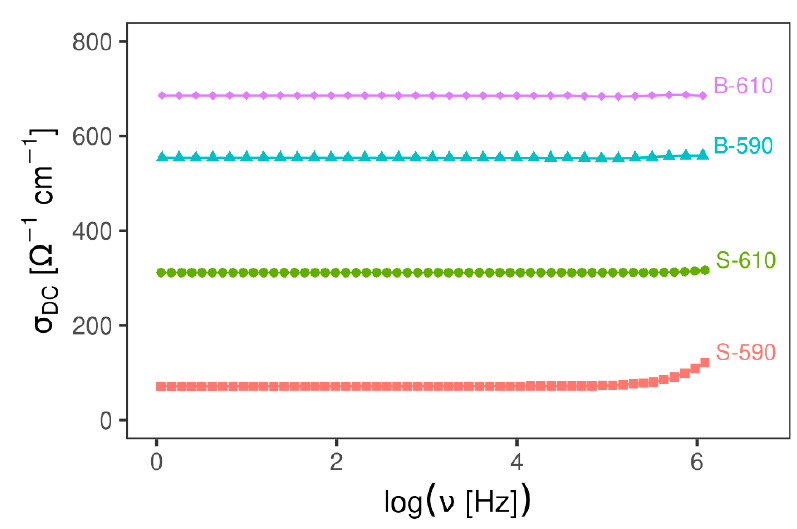
Figure 5. Electrical conductivity for SnO 2 samples as a function of frequency at 20 °C.